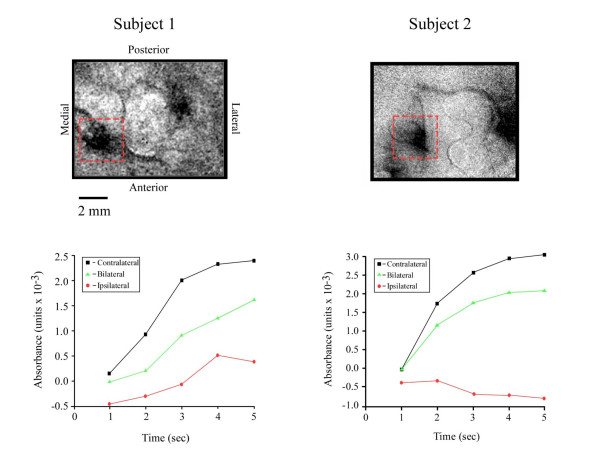
Graphs obtained from OIS data in SI cortical regions evoked by flutter stimulus on the central pad of 2 subjects. Top: Dashed box on OIS images indicates dimensions and orientation of region of interest (ROI) in SI used for analysis. Orientation and scales are identical in both subjects. Stimulus duration was 5 seconds; stimulus onset was at time 0 s. Bottom: Absorbance values within the ROI were averaged and plotted as a function of time for each stimulus condition. In both subjects contralateral stimulation evokes the largest change in absorbance, while ipsilateral stimulation evokes only a weak change in absorbance. Bilateral stimulation evokes an absorbance change that is less than that evoked by a contralateral stimulus.